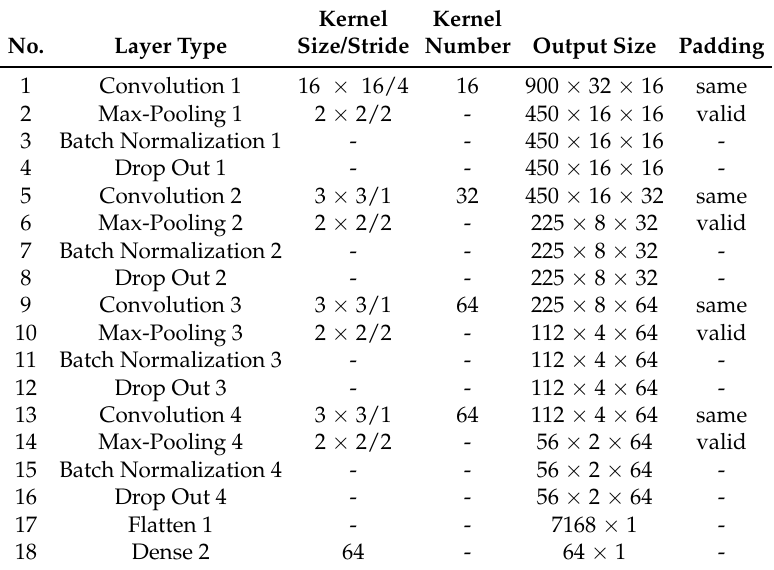
Table 2. Details of the convolutional neural networks (CNN) in the proposed one-shot learning model.